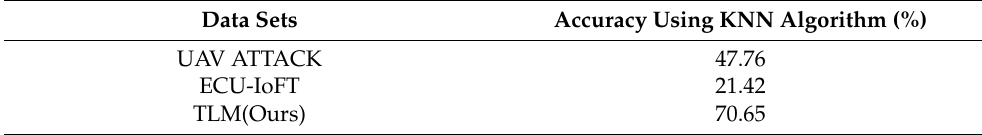
Table 10. Accuracy of using KNN algorithm on different data